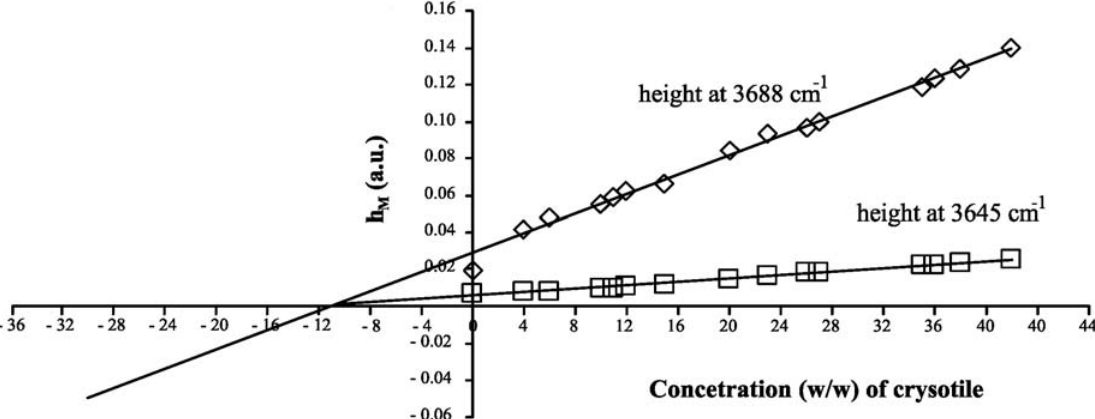
Figure 2. The Method of Additions (MoA) linear curves of